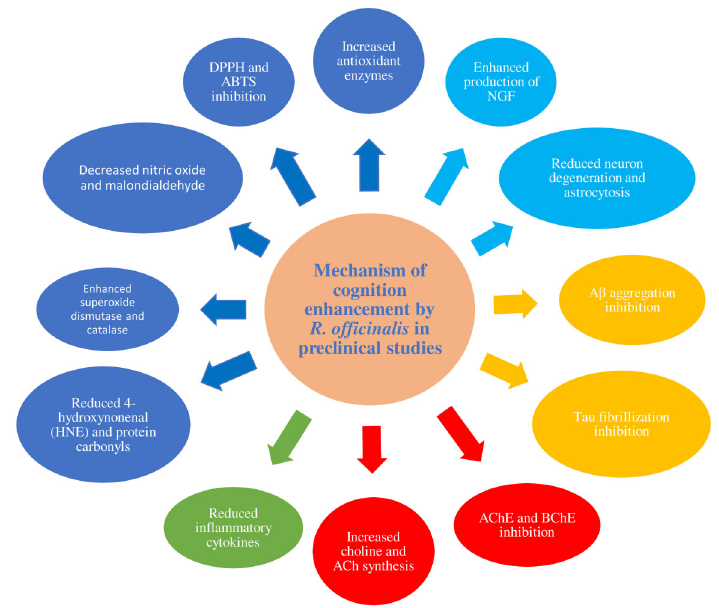
Figure 7. Mechanism of cognition enhancement by R. of fi cinalis in preclinical